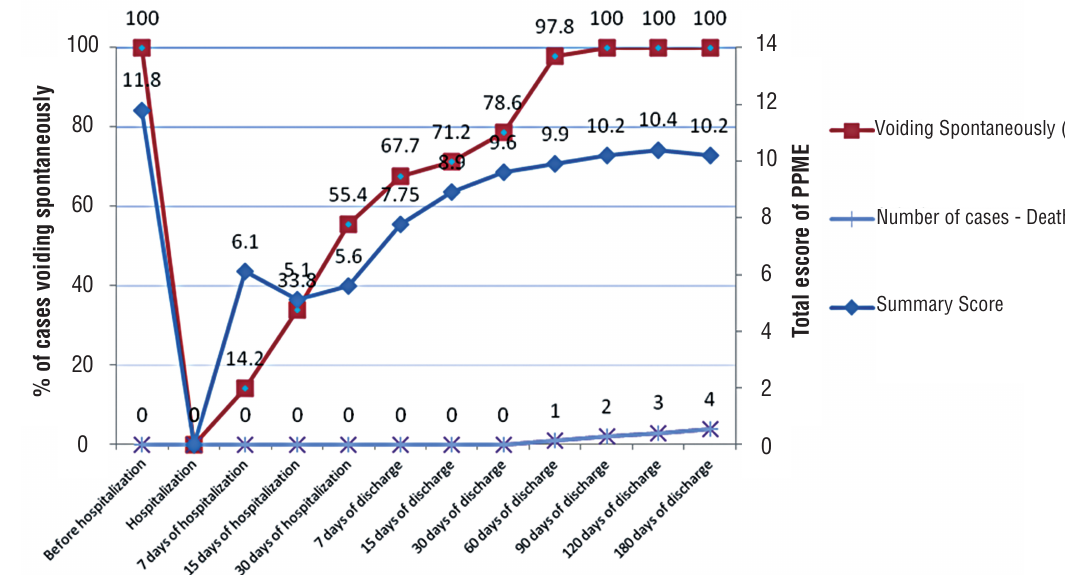
figure 4 - Evolution of recovery for spontaneous voiding matched to ppME